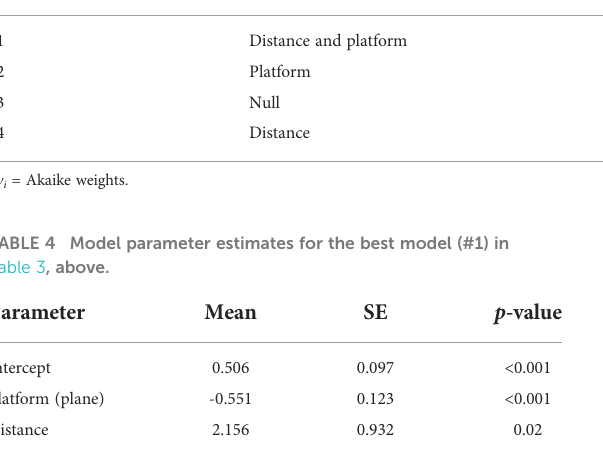
“ Front ” and “ Rear ” refer to the observers with bubble and fl at windows, respectively. TABLE 3 Models proposed to assess differences in group size estimation between boat and aircraft. Model